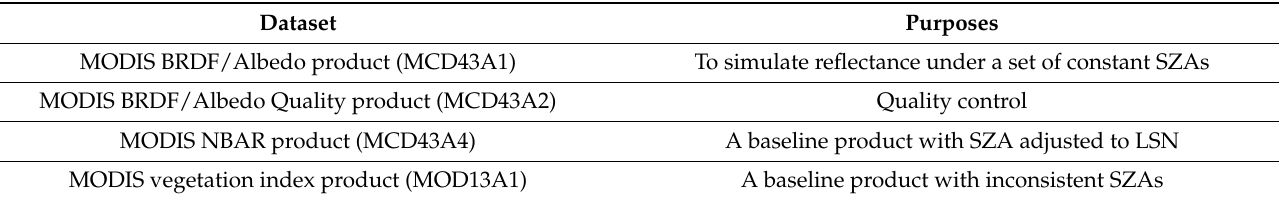
Table 1. Remote sensing